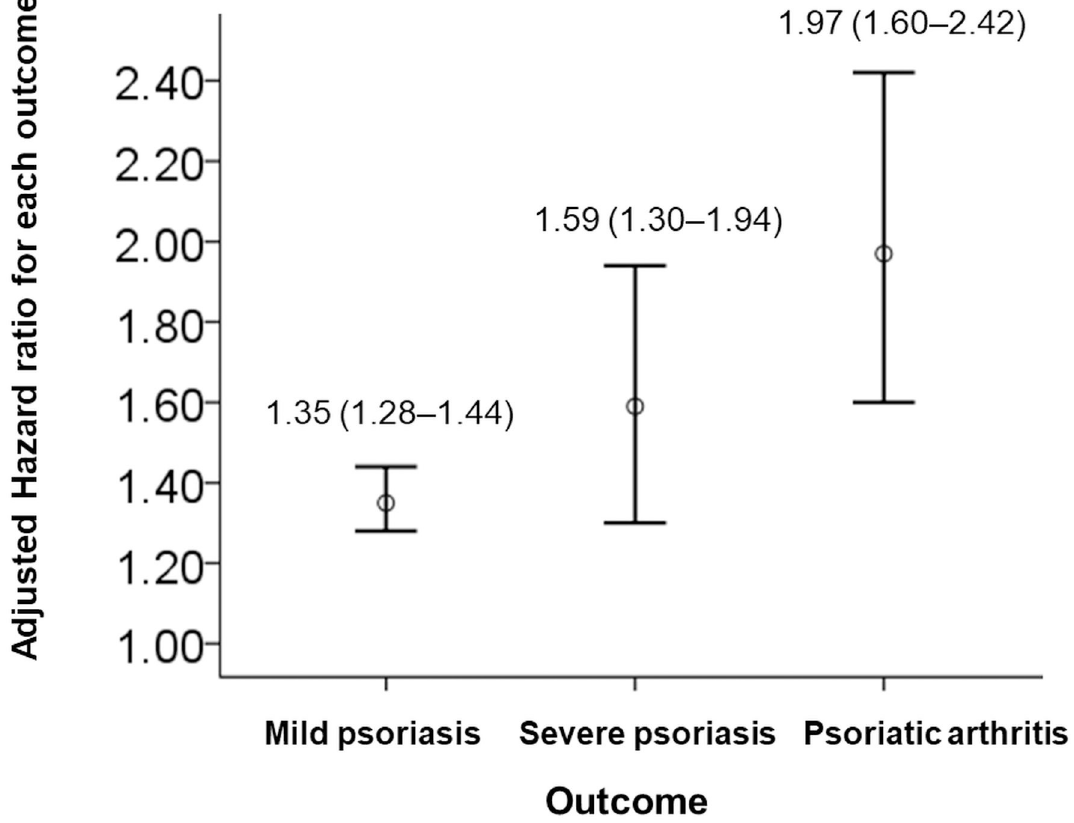
Fig 1. Adjusted hazard ratios for mild psoriasis, severe psoriasis and psoriatic